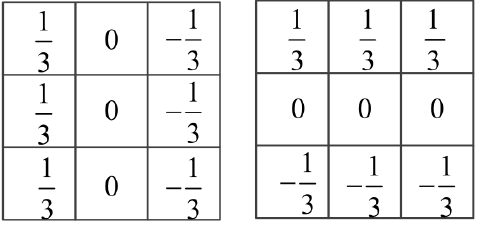
Figure 3. The Prewitt kernels in vertical and horizontal